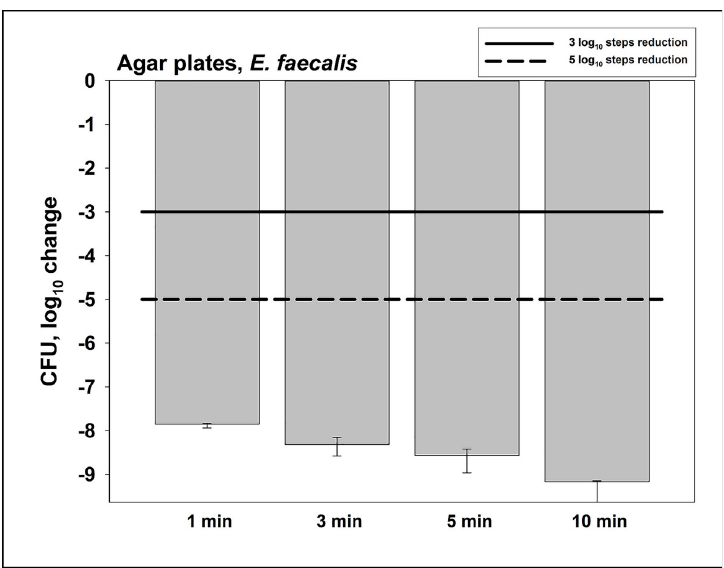
Fig 2. Antimicrobial assay towards planktonic E . faecalis on agar plates. CAP was performed for different treatment periods. Surviving colonies were counted 24 h later. All results are depicted as medians, 1 st and 3 rd quartiles from six independent experiments in duplicates on a log 10 -scaled ordinate. Bars show the reductions of CFU in a log 10 scale in comparison to untreated controls. Solid and dashed lines exhibit 3 log 10 steps (99.9%) or 5 log 10 steps reduction (99.999%) of CFU, respectively. ( n = 6; untreated controls exhibited 7.3 x 10 10 CFU in median).